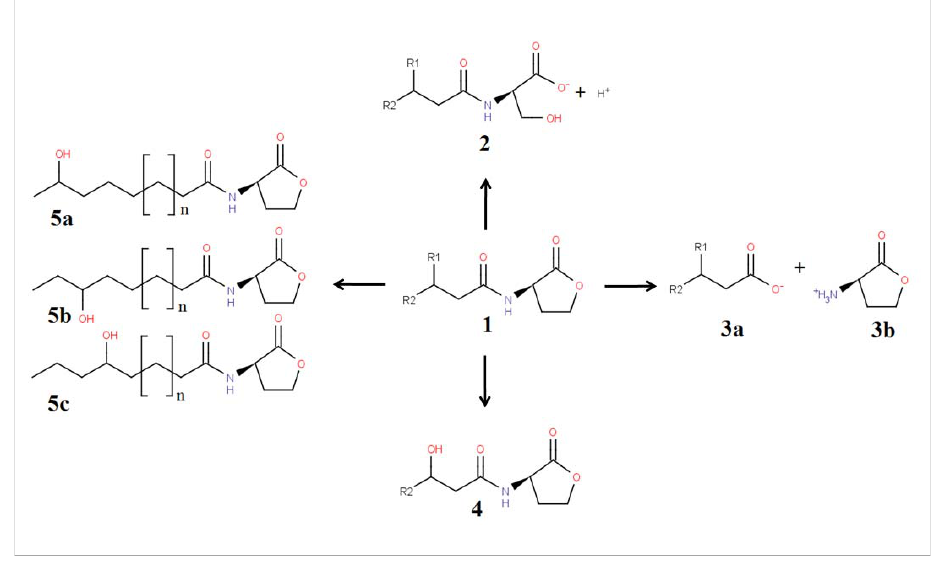
Figure 1. The signalling molecule N -acyl homoserine lactone (AHL) ( 1 ) can be degraded by lactonase, yielding N -acyl homoserine ( 2 ). Acylase cleaves the amide bond of AHL by releasing fatty acid ( 3a ) and homoserine lactone ( 3b ). Oxidoreductases from Rhodococcus erythropolis W2 and Burkholderia sp. strain GG4 inactivate AHL by substituting the oxo group at the C3 with hydroxy group ( 4 ). Similarly, CYP102A1 from Bacillus megaterium reduces the acyl chain of AHL at the ω -1, ω -2 and ω -3 positions ( 5a , 5b , 5c ). R1 corresponds to the side chain of the C3 position (3-oxo-, 3-hydroxy- and 3-unsubstituted). R2 corresponds to the acyl side chain of AHL and n corresponds to the alkyl